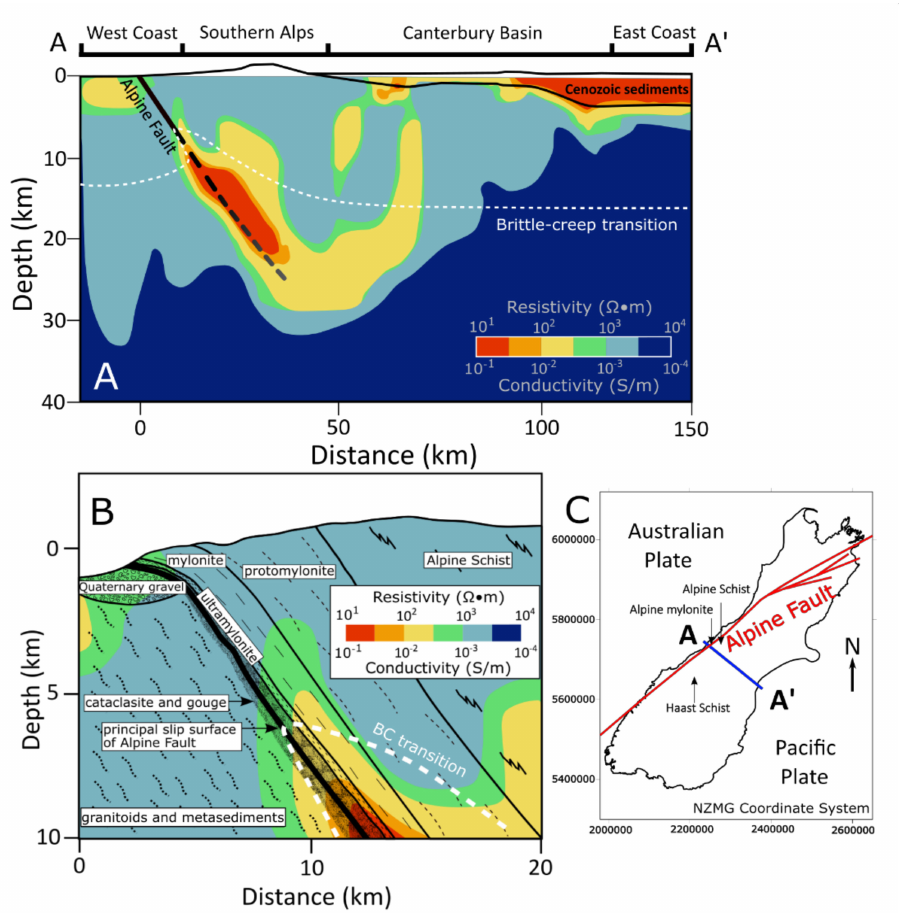
Figure 1. ( A ). Crustal-scale cross section AA’ of the Alpine Fault Zone (AFZ) conductivity structure and the surrounding crust based on magnetotelluric surveys (MT) inversions [13,20–26]. The zone of increased conductivity represents the Southern Alps Anomalous Electrical Conductor (SAEC). The brittle-creep ( B , C ) transition marks the base of the seismogenic zone and the top of the ductile shear regime. The zone of increased conductivity represents the electrical structure identified as the SAEC. ( B ). Smaller scale cross-section of the SAEC with associated fault rocks and geologic units [13,20–27]. ( C ). Regional map of South Island, New Zealand, showing the Alpine Fault trace, the cross-section extent and sample